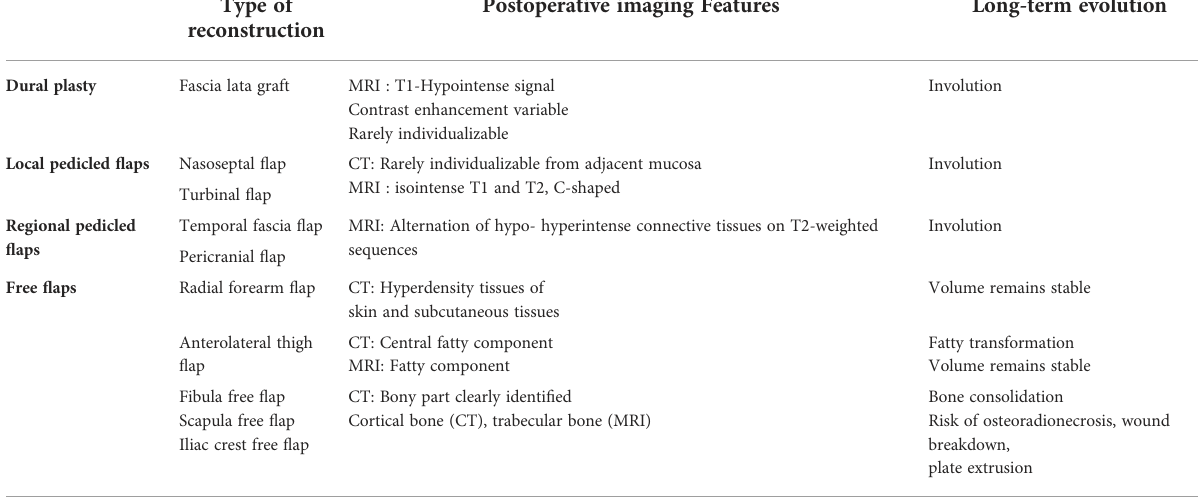
TABLE 1 Types of various surgical fl aps used in sinonasal cancer surgery, postoperative & long-term follow-up imaging features. Type of